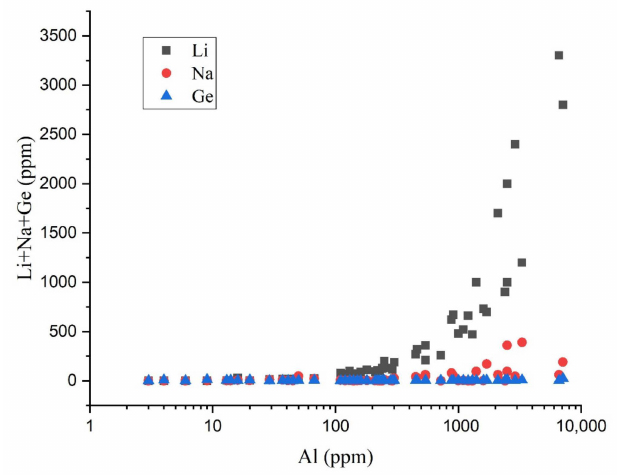
Figure 9. Demonstration of the relation between Al and Li, Na, and Ge. Li is the only element that strongly correlates with Al concentration